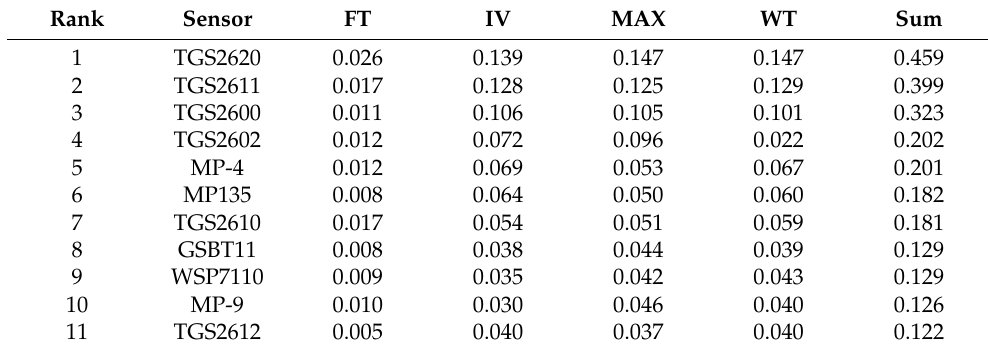
Table 6. Overall importance ranking of sensors.